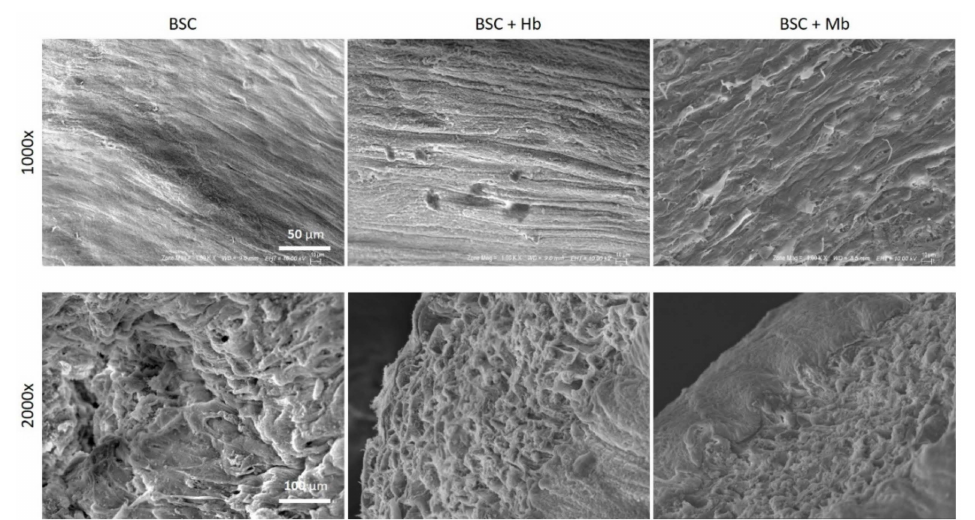
Figure 7. Scanning electron microscopy images of BAMs. BAMs generated from BSC, BSC + Hb, or BSC + Mb (3 mg / mL for both heme proteins) were dehydrated and sputter coated with gold. Images were taken in 1000 × magnification (scale bar = 50 µ m) in the center of the tissue and 2000 × magnification (scale bar = 100 µ m) from the side of the